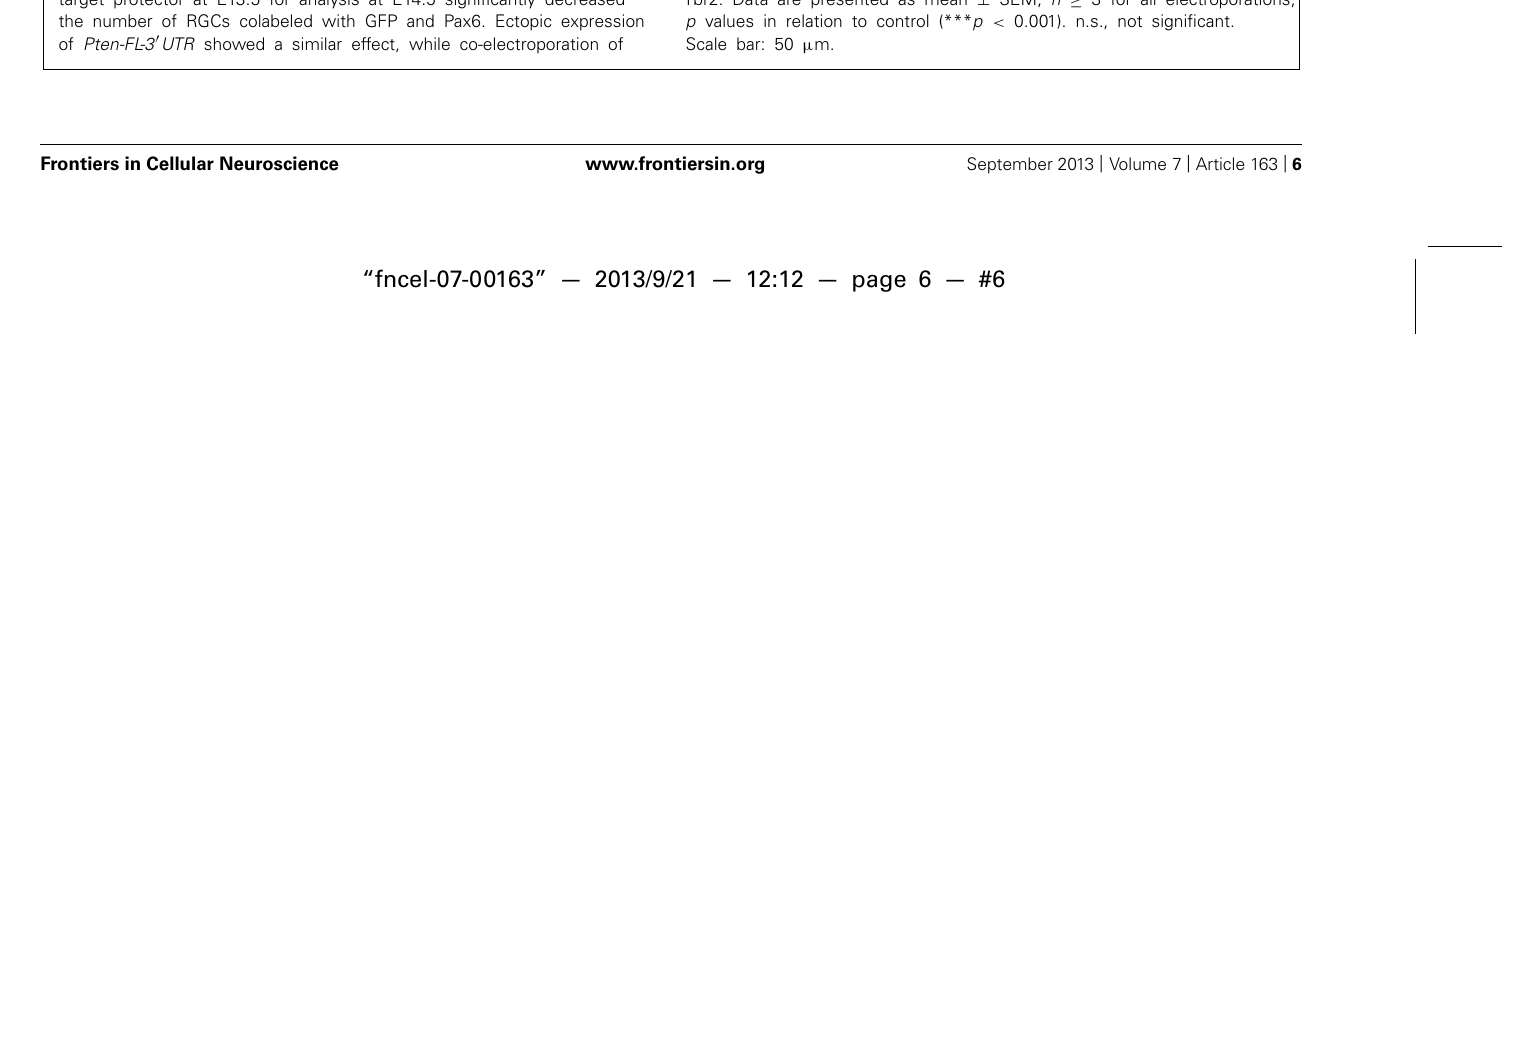
FIGURE 5 | miR-19a targeting of Pten is responsible for RGC expansion in the developing mouse cortex. (A,B) miR-19a targeting of Pten is important for RGC expansion. Introduction of the 60 nt target protector at E13.5 for analysis at E14.5 significantly decreased the number of RGCs colabeled with GFP and Pax6. Ectopic expression of Pten-FL-3 (cid:2) UTR showed a similar effect, while co-electroporation of